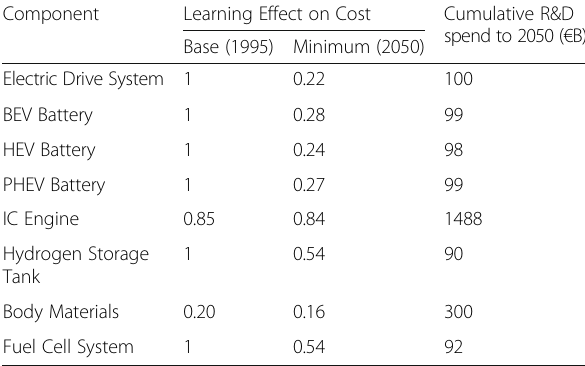
Table 4 Effect of learning on cost and cumulative manufacturer spend of individual components under base